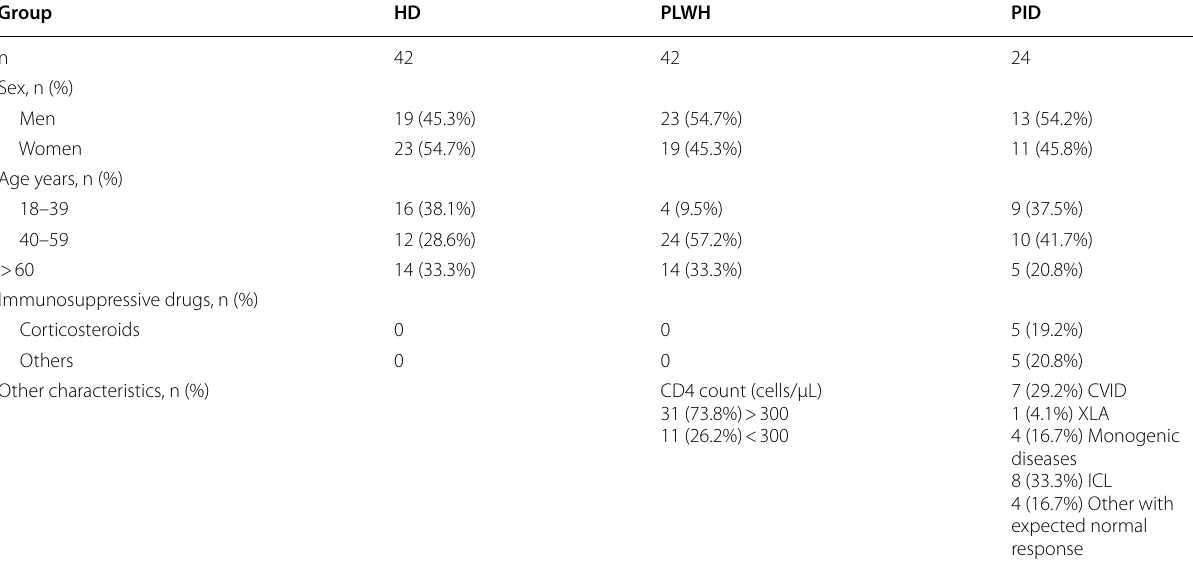
Table 1 Vaccine recipient study